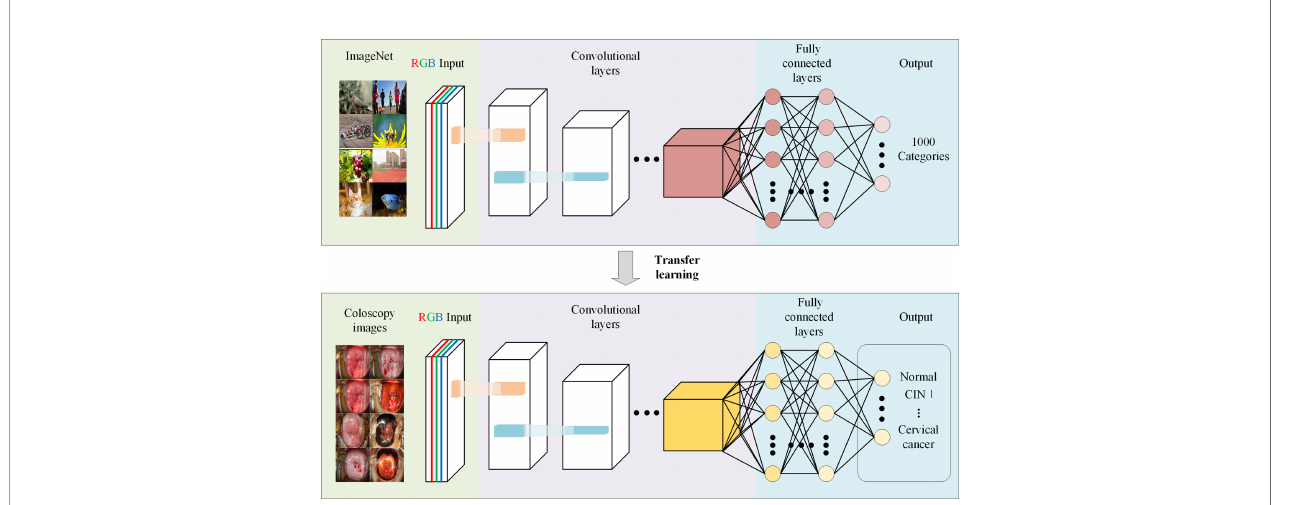
FIGURE 4 | Schematic representation of application of Convolutional Neural Network in colposcopy images. Schematic depicting that a CNN pre-trained on other large-scale image datasets can be adapted to signi fi cantly increase the accuracy and shorten the training duration of a network trained on a novel dataset of colposcopy images.